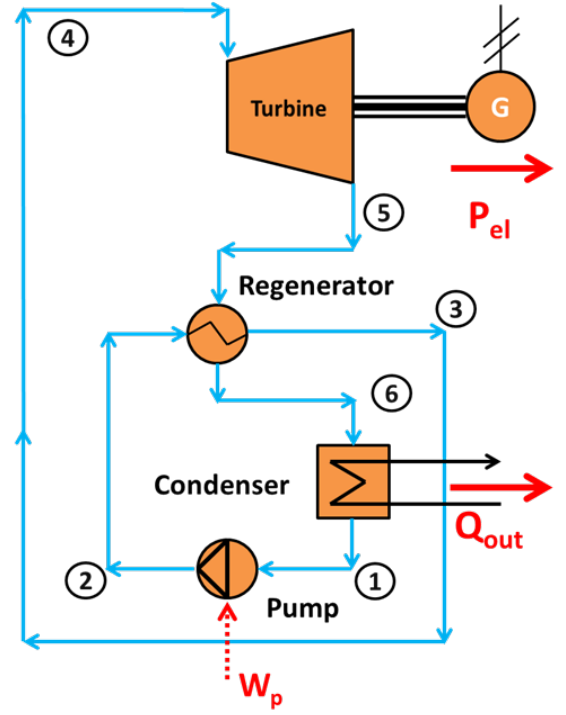
Figure A1. The basic regenerative organic Rankine cycle.